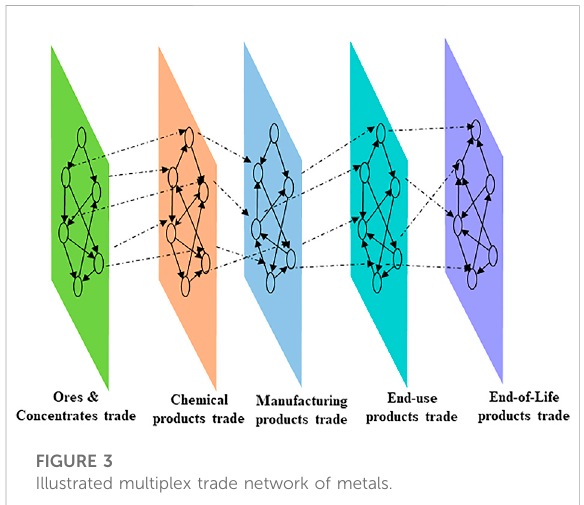
FIGURE 3 Illustrated multiplex trade network of